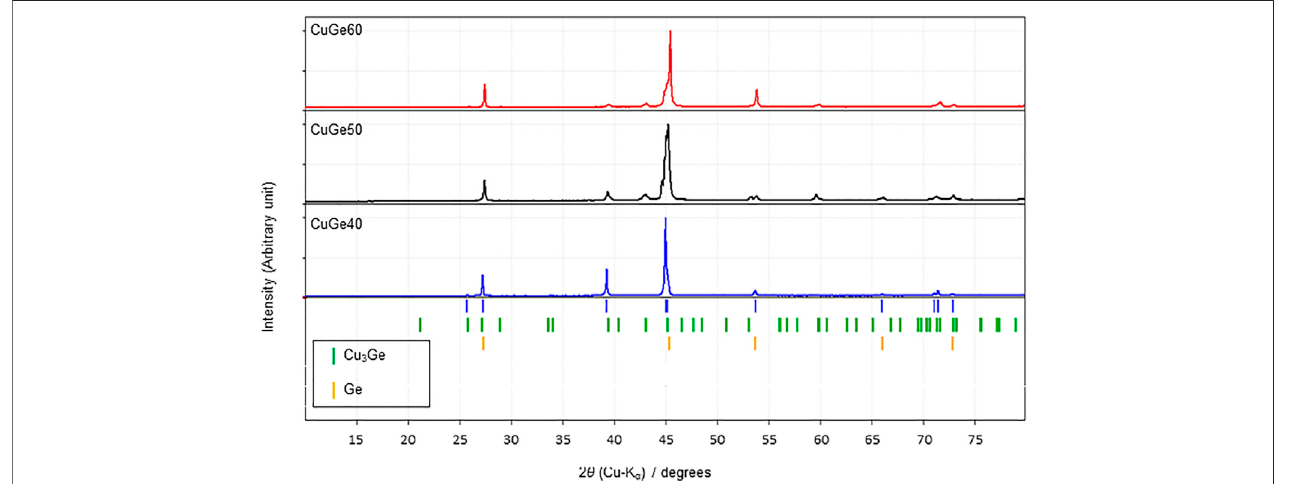
FIGURE 3 | XRD patterns of synthesized CuGe40, CuGe50, and CuGe60